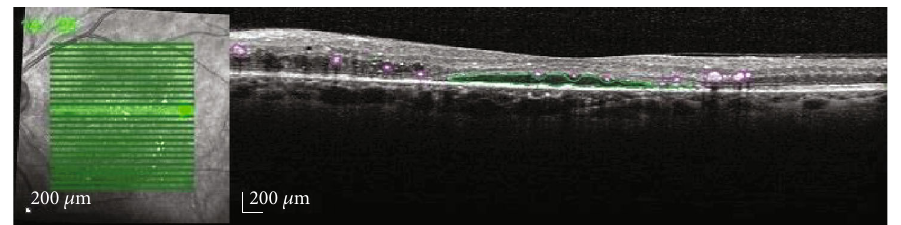
Figure 1: Macular OCT image revealing SND and